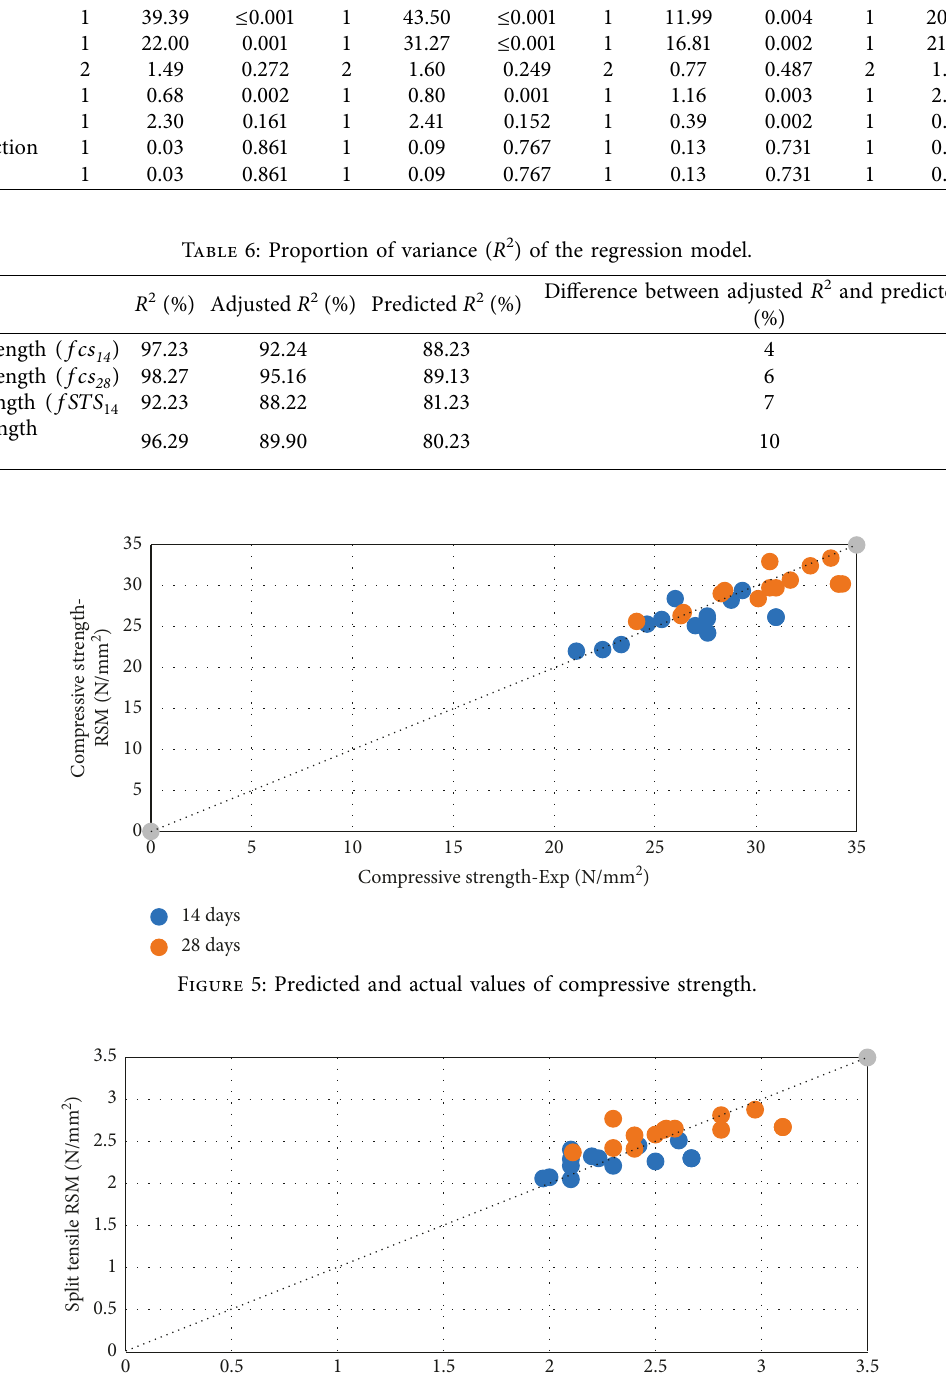
Table 5: ANOVA for fcs